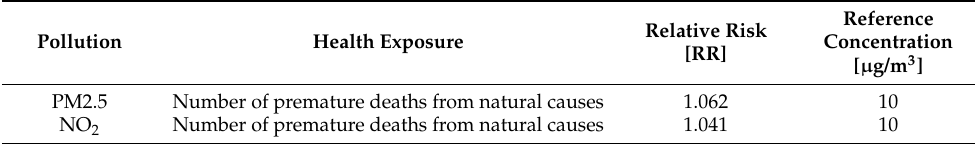
Table 1. Assumed relative risks and reference concentrations for the health impacts from exposure analyses